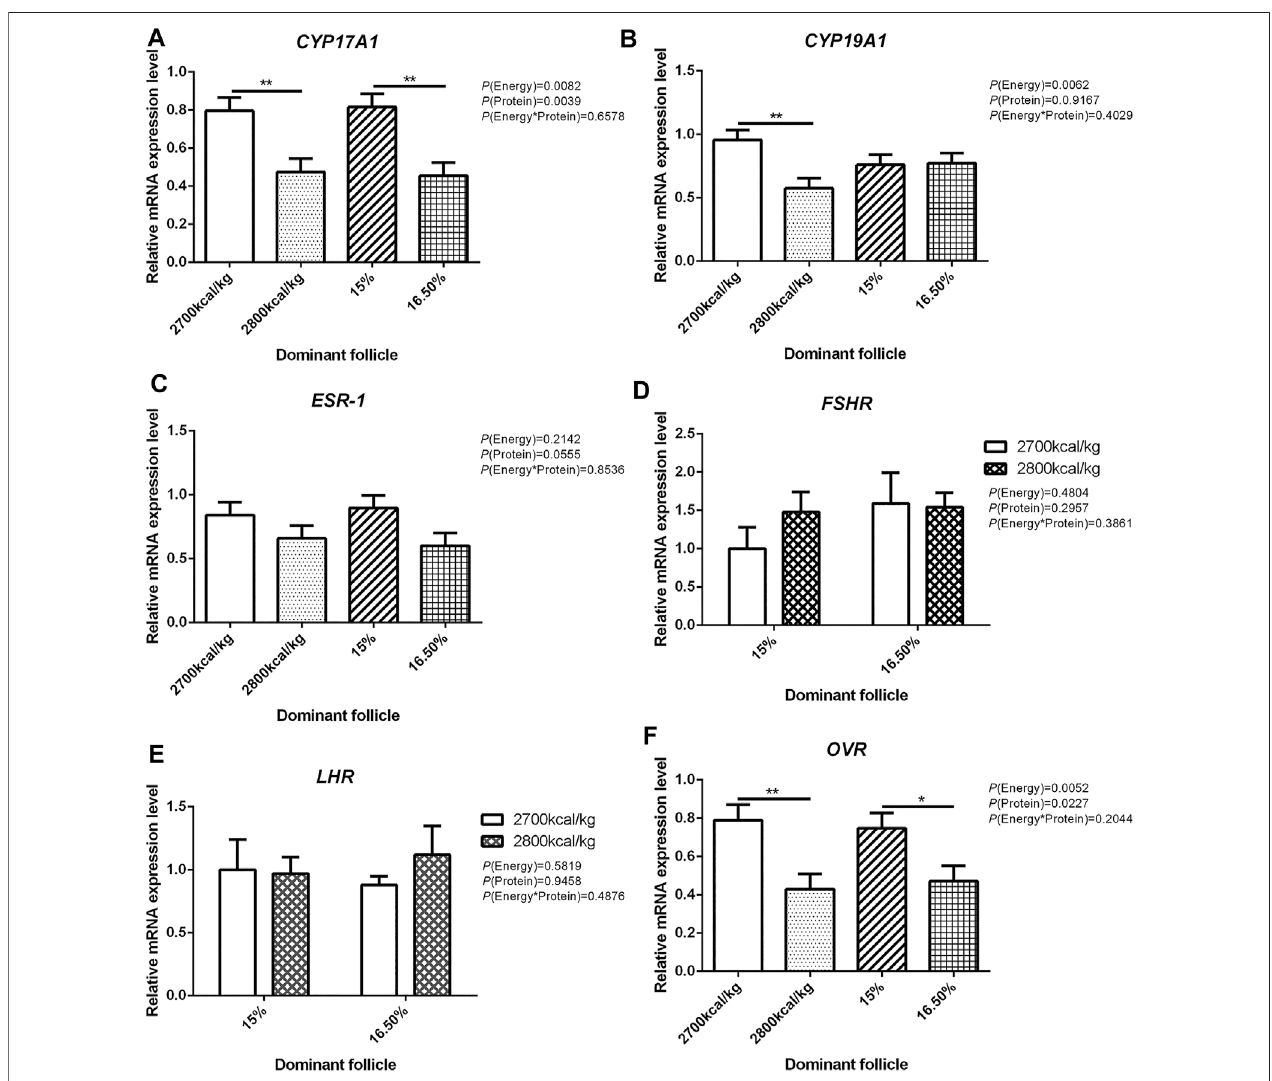
FIGURE6 | Effect of dietary metabolizable energy (E) and crude protein (P) levels during the prelay period (15 – 20 weeks of age) on themRNA expression of genes CYP17A1 (A) , CYP19A1 (B) , ESR-1 (C) , FSHR (D) , LHR (E) , and OVR (F) in the dominant follicles ofhens. Data represent the mean ± SD ( n = 4); p p < 0.05, pp p < 0.01.